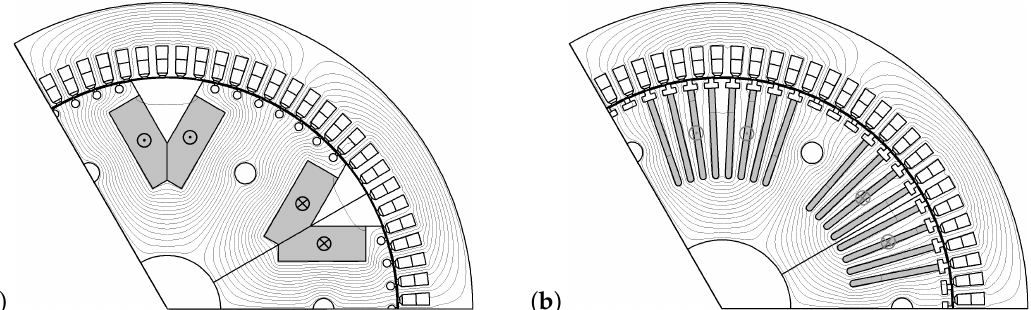
Figure 7. FEM simulation results in no-load conditions: ( a ) commercial salient pole field BSG; ( b ) prototype cylindrical field BSG (marked direction of current in field